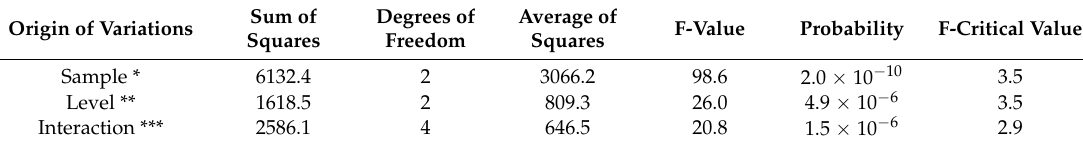
Table 3. Results of analysis of variance (ANOVA) obtained from data of Figure 1.